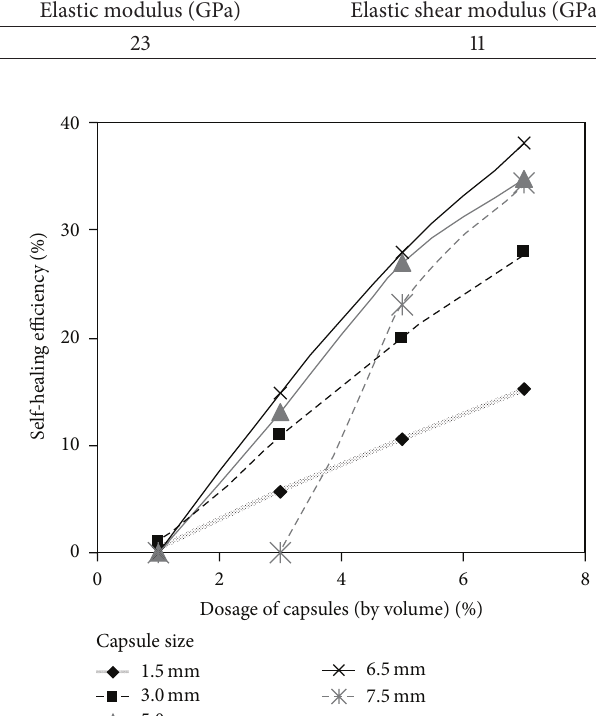
Figure 16: The self-healing efficiency with different amount of